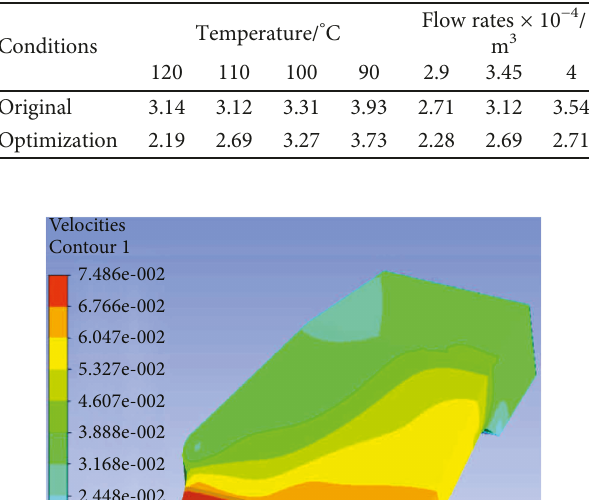
Figure 8: Response surface plots of the SDV as a function of outlet width D and angle B . Table 8: SDV at di ff erent temperatures and fl ow ratios.